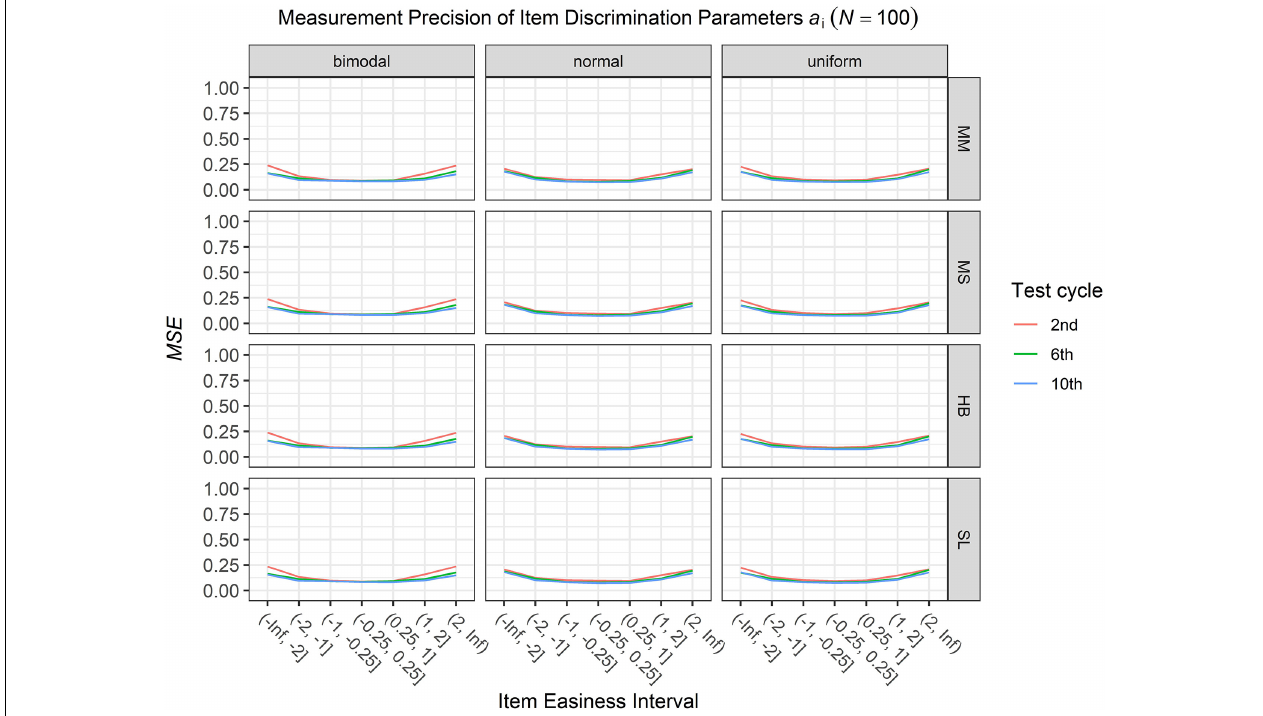
FIGURE 2 | Conditional mean squared error ( MSE ) of the item discrimination a i for specific item easiness intervals after the 2nd, 6th, and 10th test cycle in the continuous calibration strategy with a sample size per test cycle of N = 100 for different common item difficulty distributions and different scale transformation methods (MM = Mean/Mean, MS = Mean/Sigma, HB = Haebara, SL =